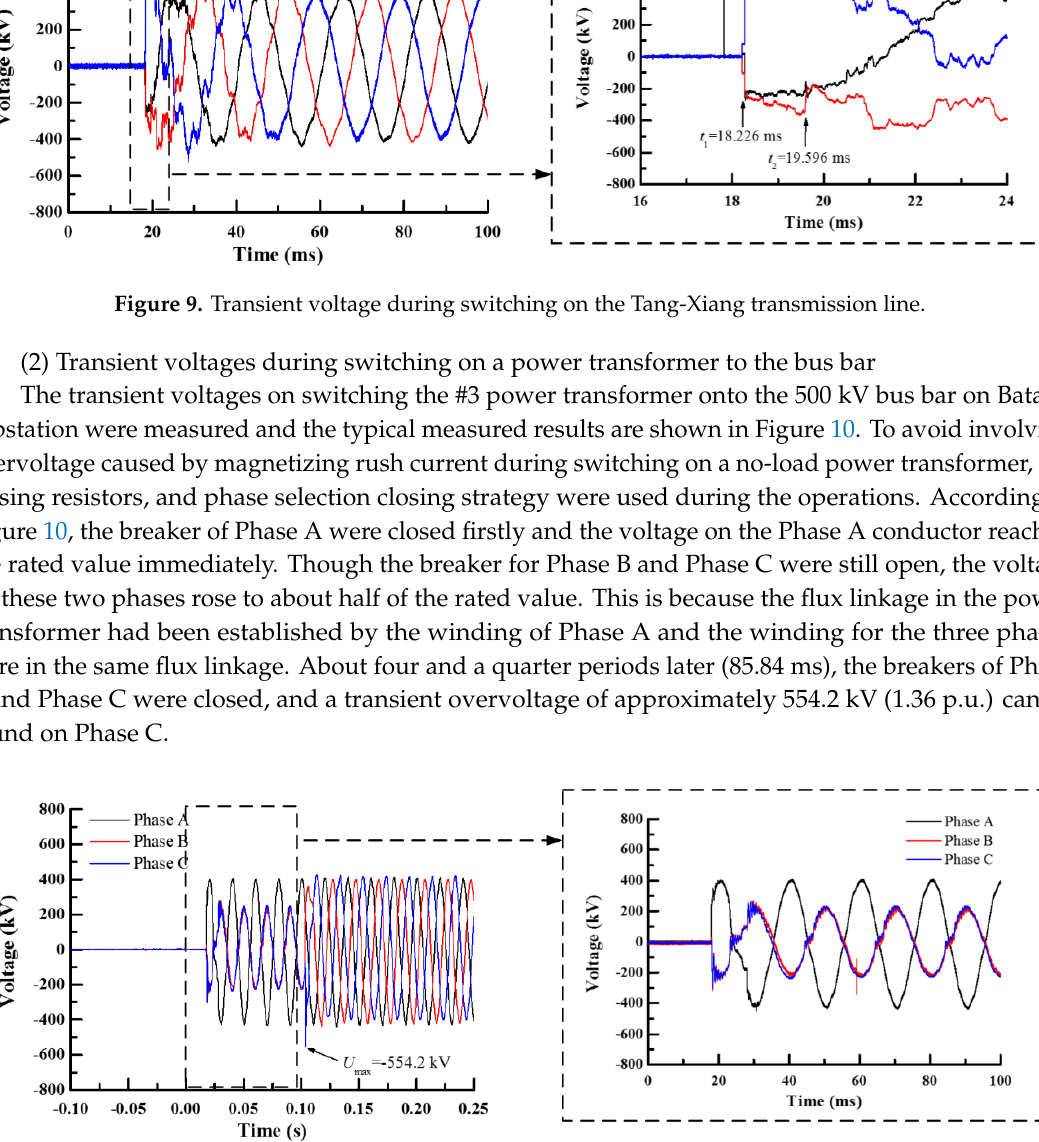
Figure 10. Transient voltage during switching on the #3 power transformer on Batang substation.